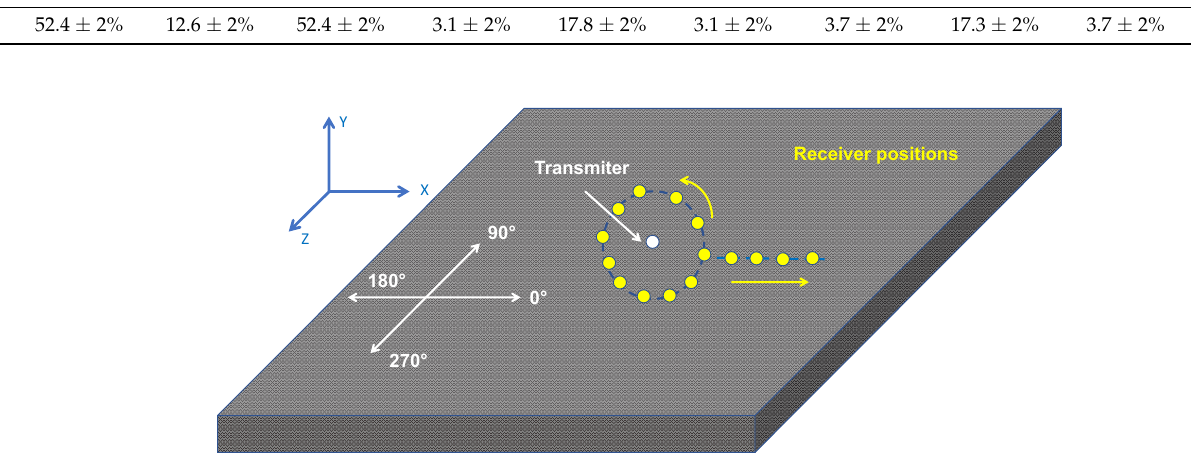
Figure 1. Schematic for measuring group velocities of A 0 and S 0 Lamb wave modes.